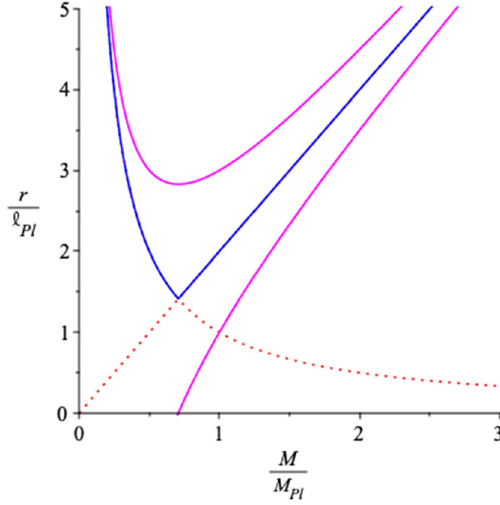
Fig. 1 The blue lines show the Schwarzschild and Compton scales, the Schwarzschild solution being self-complete in the sense that the intersection gives the smallest resolvable length scale. The red dotted lines give the (inaccessible) continuations of these curves. The upper magenta curve shows the unified Compton and Schwarzschild scale ( r CS ) if the BHUP correspondence with β > 0 applies. The lower magenta curve applies for β < 0 but this does not provide a unification